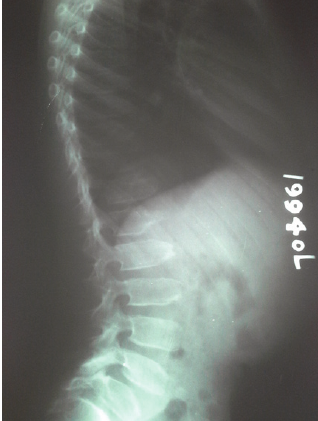
Figure 1: Platyspondyly with and anterior end plate abnormalities with defective ossification and anterior beaking of vertebral bodies.